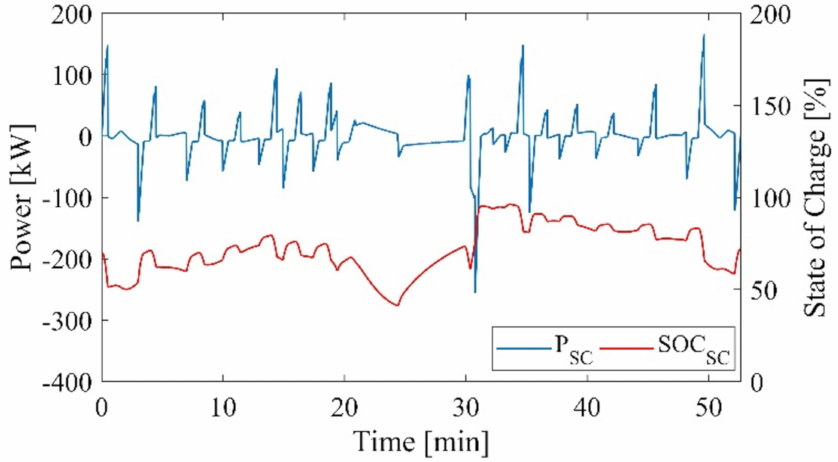
Figure 7. Supercapacitor